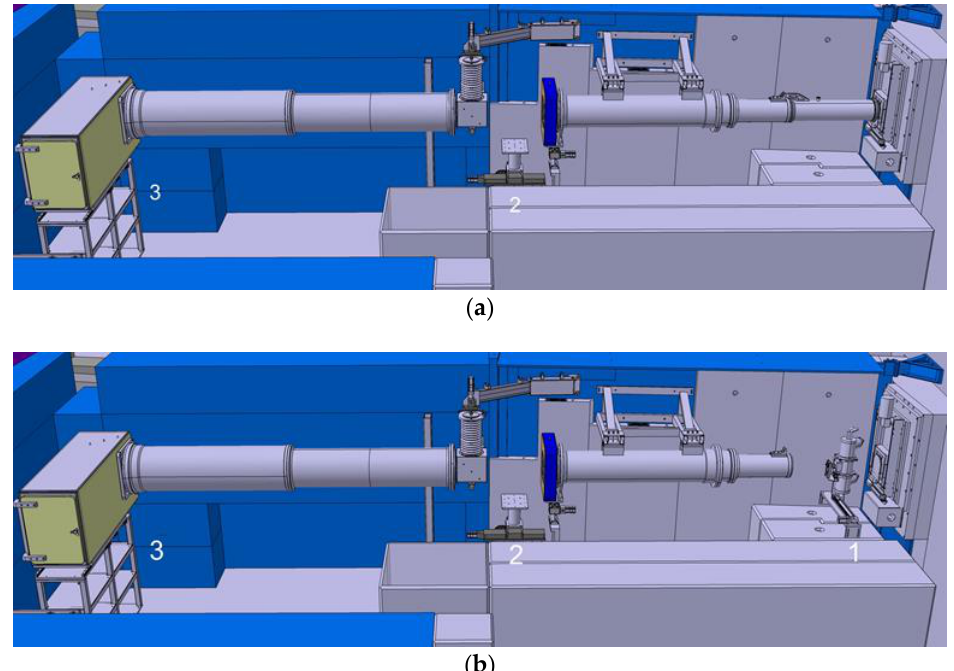
Figure 2. ( a ) Original standard configuration of NEUTRA using the thermal beam from the SINQ D 2 O moderator; ( b ) NEUTRA layout with X-ray tube at Position 1 in operating position; (shielding removed in images to enable visibility); the beams come from the right-hand side in this drawing. The length of the shown outer collimator is on the order of 10 m.